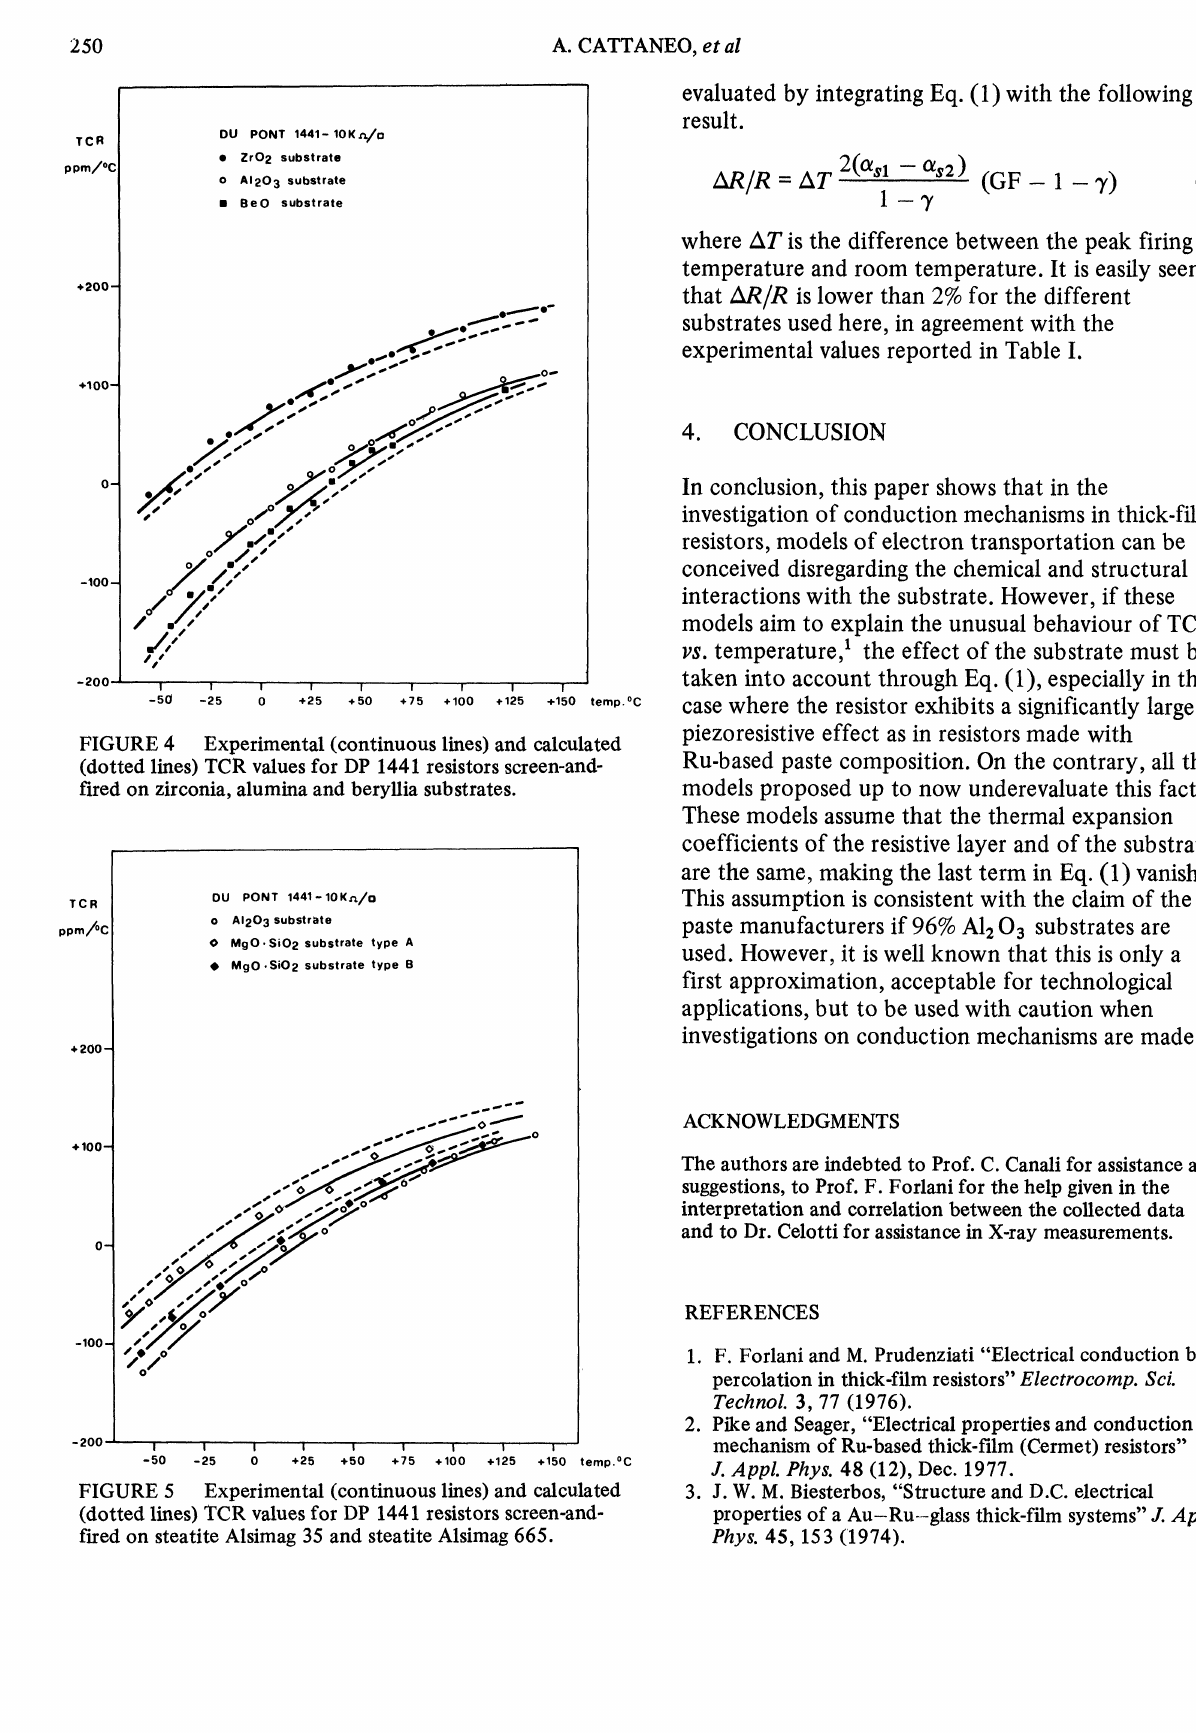
Experimental (continuous lines) and calculated (dotted lines) TCR values for DP 1441 resistors screen-and- f’tred on steatite Alsimag 35 and steatite Alsimag